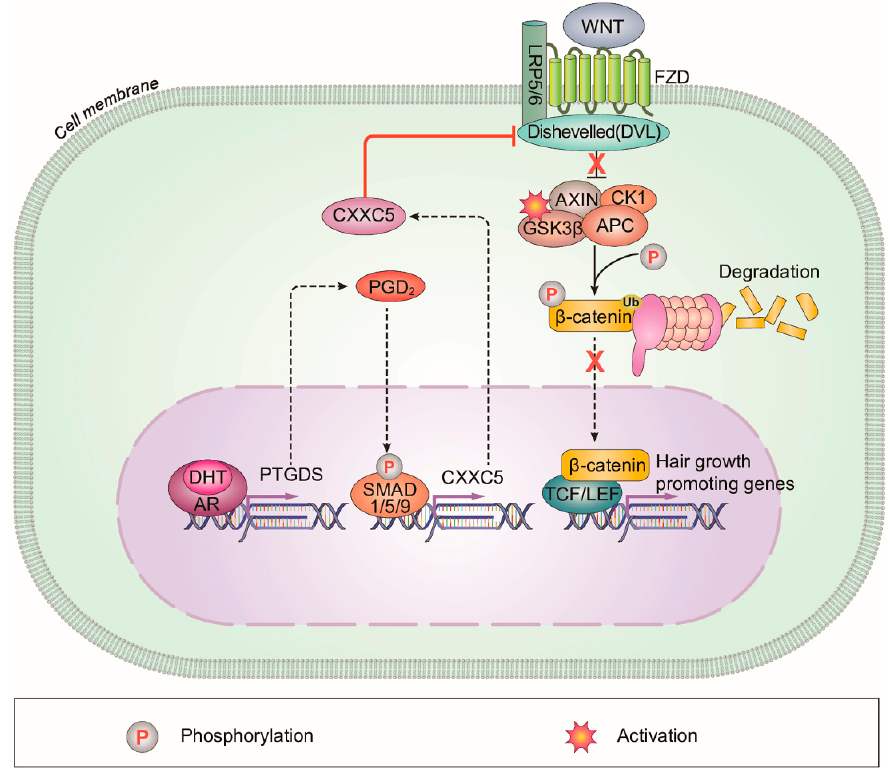
Figure 6. A schematic model for the DHT-induced alopecia mediated via PGD 2 –CXXC5 axis. CXXC5 plays a role as a mediator of DHT-induced androgenetic alopecia via PGD 2 . CXXC5 is induced by DHT-PGD 2 to suppress the Wnt/ β -catenin signaling.